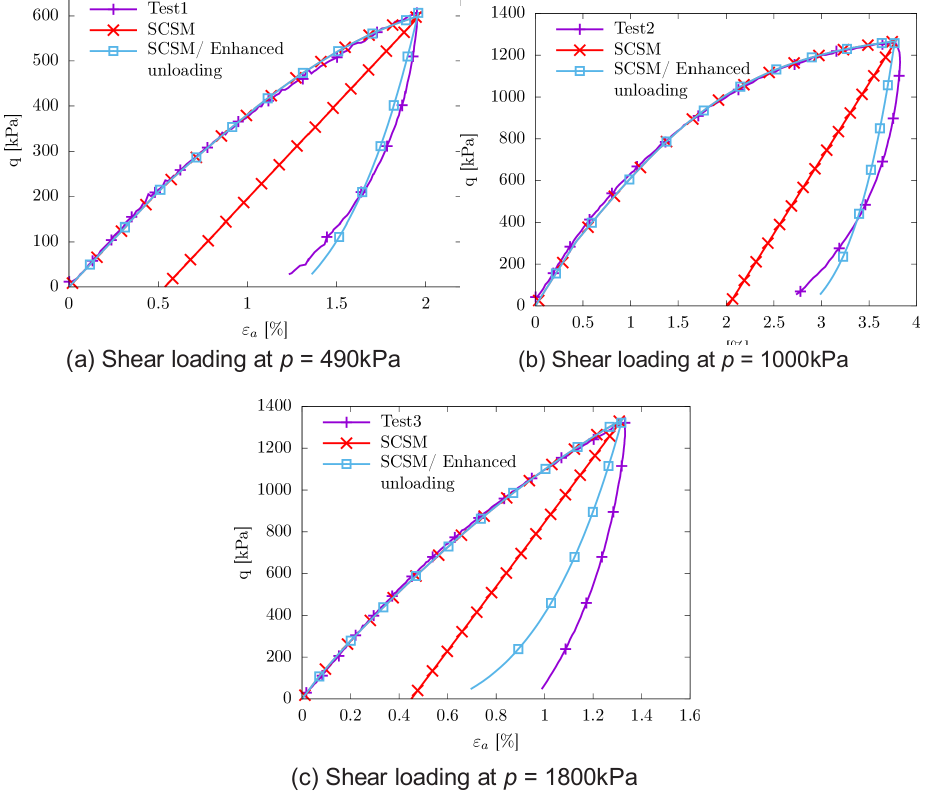
Figure 11: Enhancement of the unloading simulation